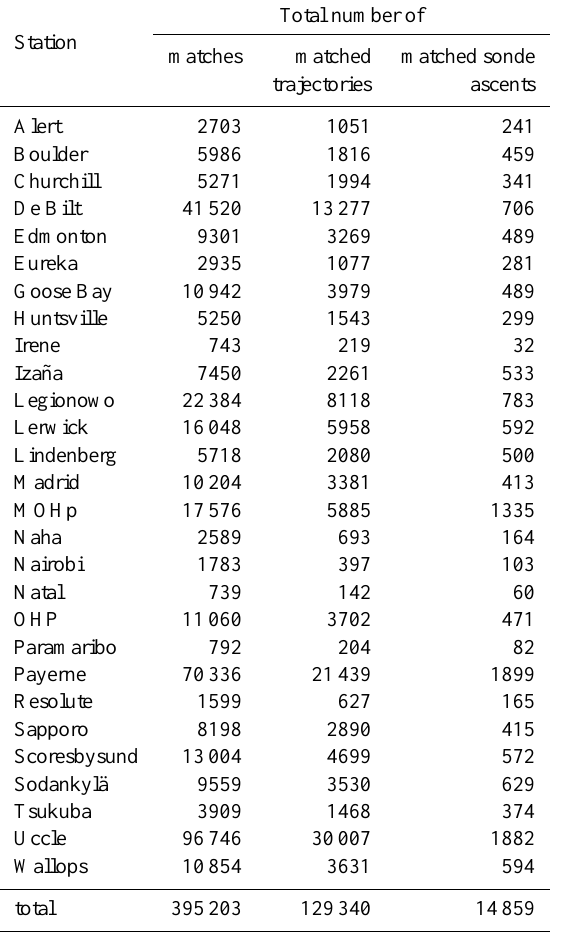
Table 2. Total number of matches, matched trajectories and ascents used for the different launch sites included in this